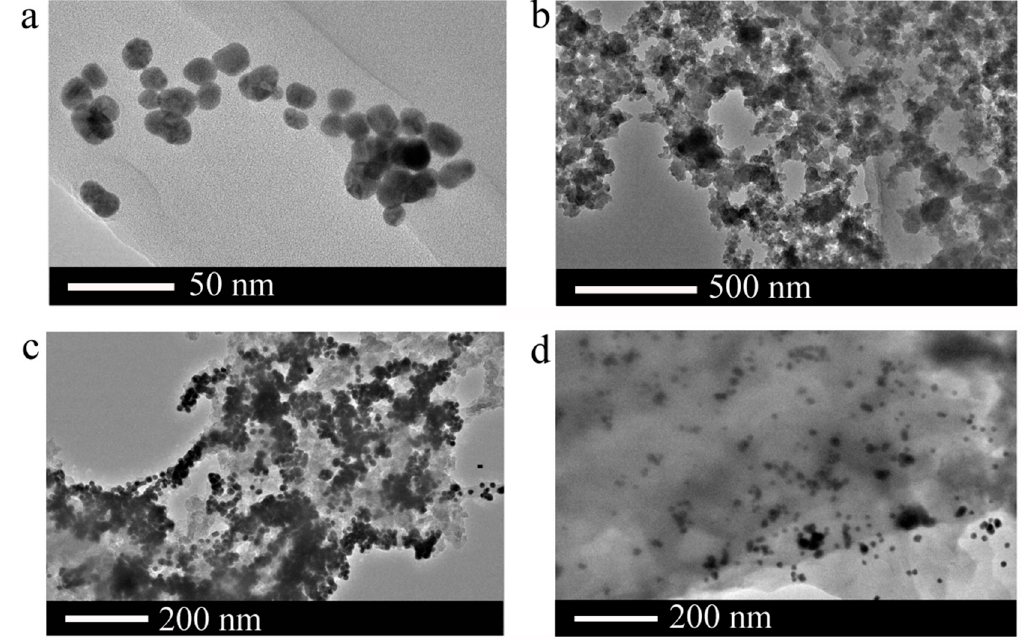
Figure 1. HR-TEM images of ( a ) AuNPs; ( b ) SiNPs; ( c ) AuNPs-SiNPs at the absence of L-Cys and ( d ) AuNPs-SiNPs in the presence of L-Cys.